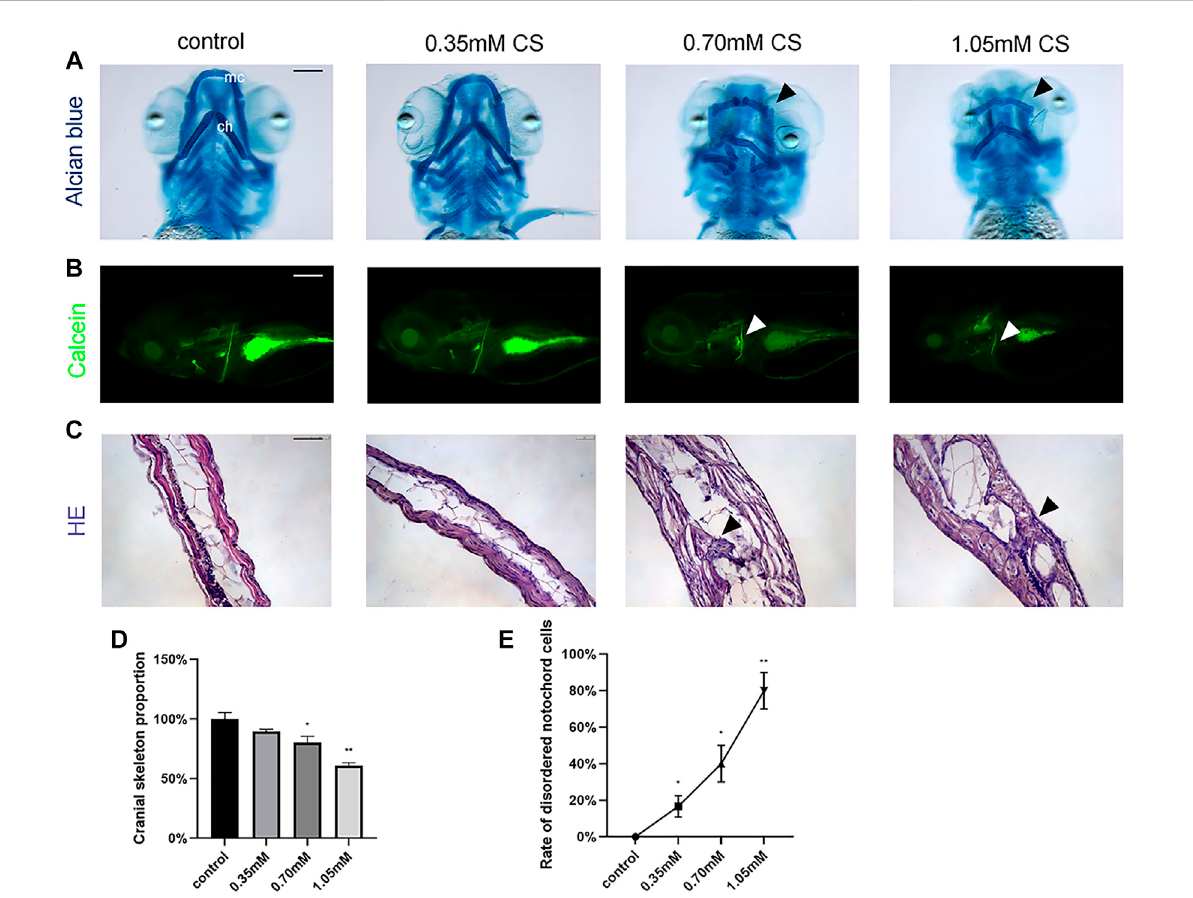
FIGURE 2 Skeletalstainingofembryosafterexposuretocysteamine. (A) Alcianbluestainingofzebra fi shlarvaecraniofacialskeletonexposedto0.35,0.70, and 1.05 mM cysteamine at 72 hpf. (B) Calcein staining of the whole-mount skeleton of zebra fi sh larvae exposed to 0.35, 0.70, and 1.05 mM cysteamine at 120 hpf. Arrows indicated abnormal craniofacial skeletal structure and chondropenia. mc: meckel ’ s cartilage, ch: ceratohyals. (C) HE stainingoftheskeletonofzebra fi shlarvaeexposedto0.35,0.70,and1.05 mMcysteamineat72 hpf.Arrowsindicateddisorderedaccumulation of notochord cells and abnormal tissue vacuoles. (D) The craniofacial skeleton area of zebra fi sh larvae exposed to 0.35, 0.70, and 1.05 mM cysteamineat 72 hpf. (E) Rate of disordered notochord cells in zebra fi sh larvae exposed to 0.35, 0.70, and 1.05 mM cysteamine at 72 hpf. Scale bars: 50 μ m (A,C) , 100 μ m (B) . * p < 0.05, ** p < 0.01, *** p < 0.001, mean ±